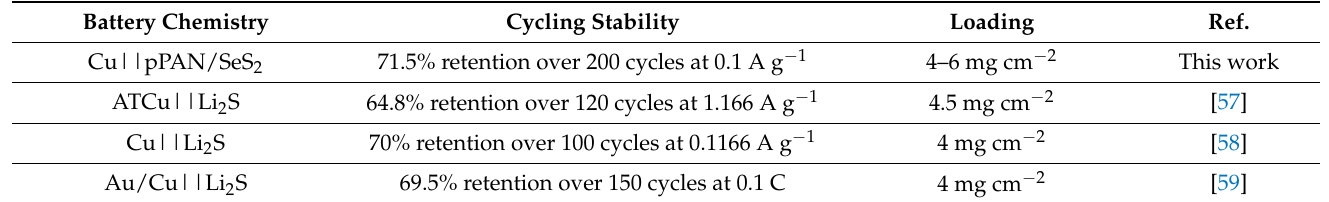
Figure 4. ( a ) Cycling stability; ( b ) Galvanostatic current charge–discharge curves of moderate mass loading and lean electrolyte Cu||pPAN/SeS 2 half – cells. Table 2. Performance comparison of anode-free Li-S batteries between this and reported